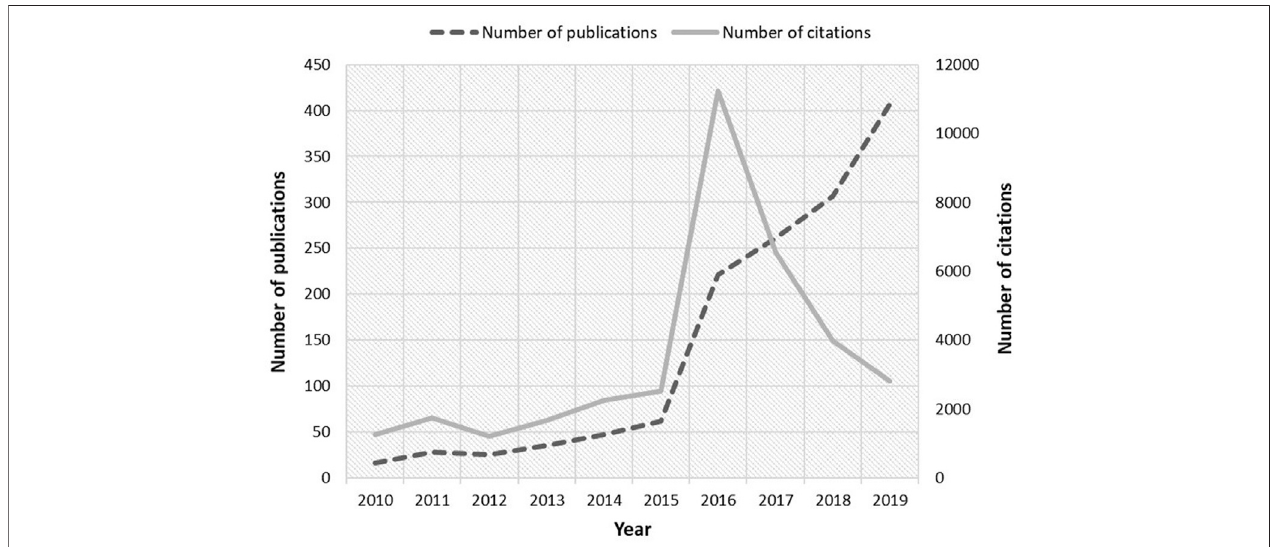
FIGURE 1 | Growth of publications and citations for polymyxin resistance (2010 – 2019).